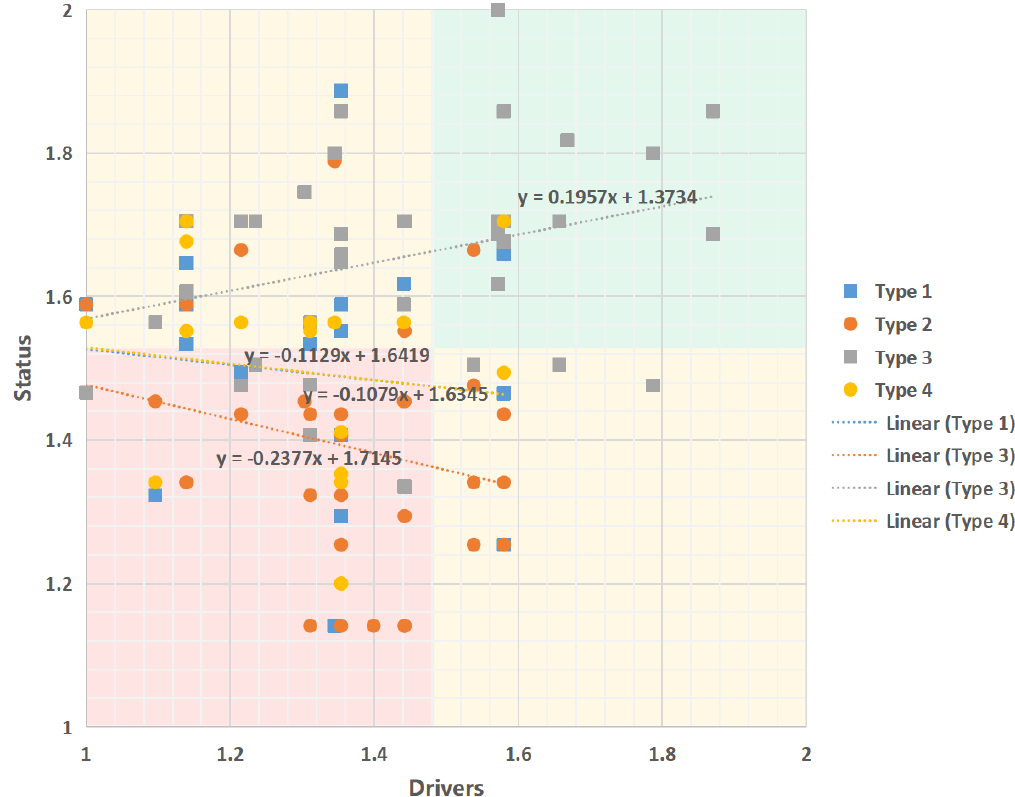
Figure 7. Renewal timing evaluation.